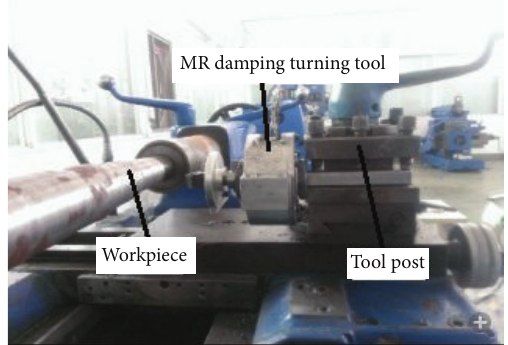
Figure 2: Structural diagram of MR damping turning